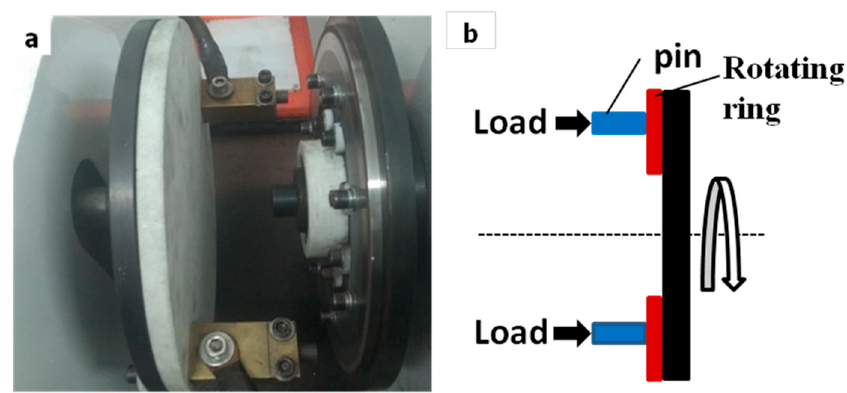
Figure 2. Pin-on-ring tribometer illustration: ( a ) test machine; ( b ) schematic of pin-disc tribometer.